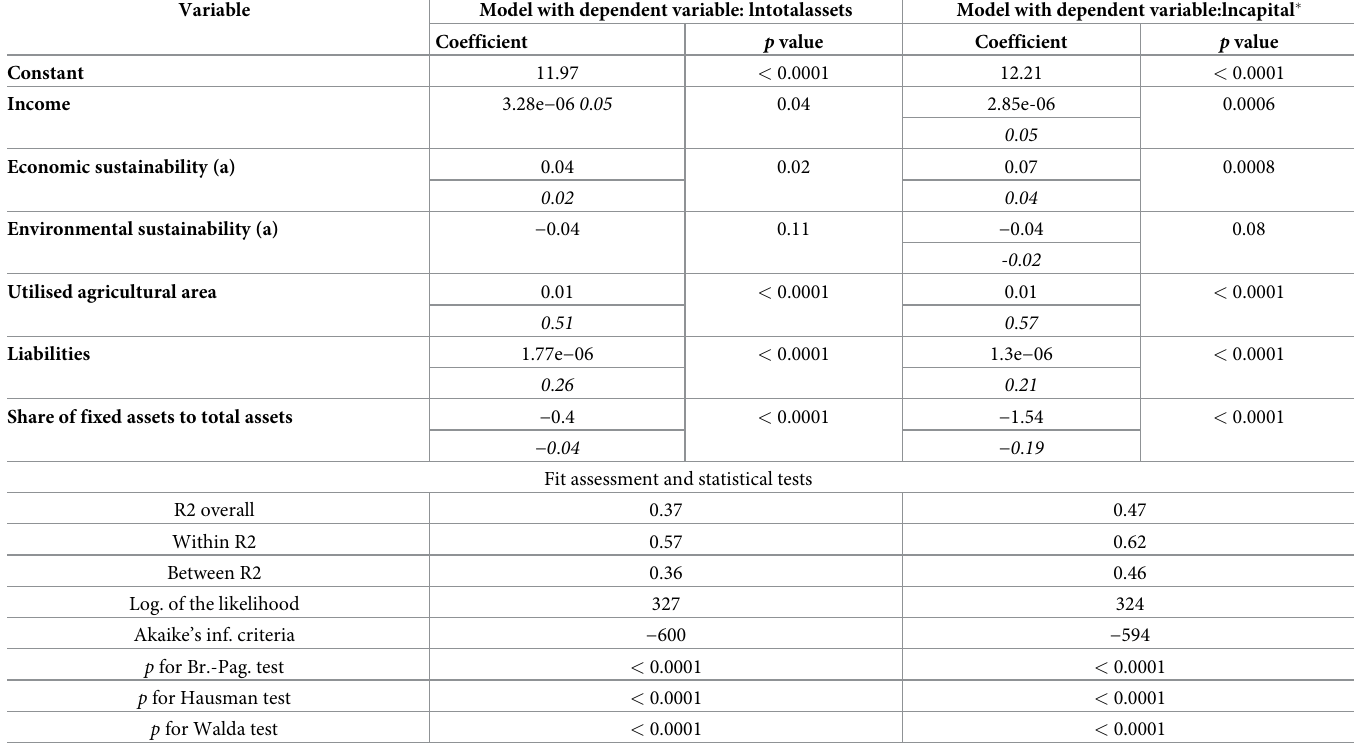
The relationship between assets and income in the group of studied farms turned out to be statistically significant (Table 3). An increase in income by one unit caused an increase in assets by 0.000328%. Furthermore, the variation in assets across countries was much higher than that within the given units (time variable). Hence, the fit of the R2-within model reached a higher value than that of the R2-between model. Higher R2-within is due to the significant heterogeneity of farms and the associated inertial nature of changes in production structures over time. Table 3. The panel models for the relationship between agricultural income and farm assets or capital (FADN system) in EU21 countries (2004–2018; fixed effect estimation). Beck–Katz robust standard errors.